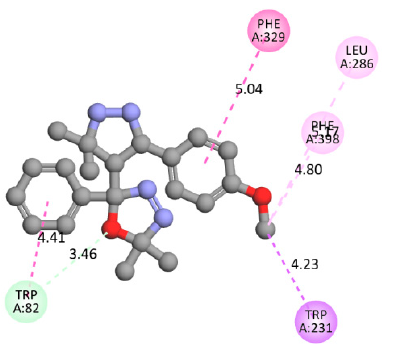
Figure 9. 2D depiction of docking of ligands 1HP14 and 1HP24 in the active site of AChE (PDB ID: 1EVE).